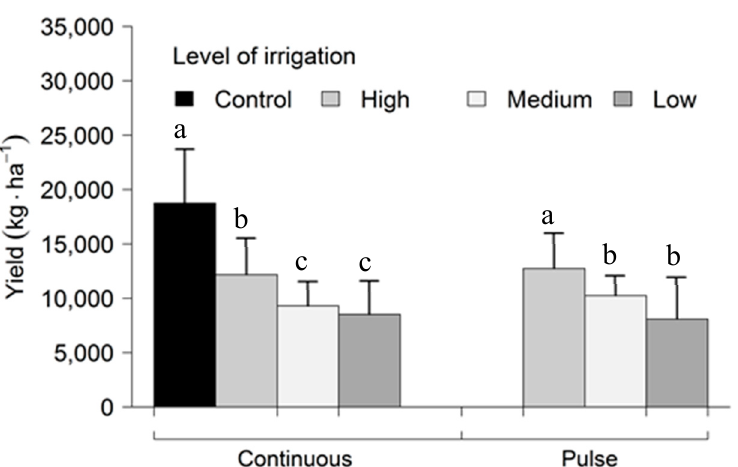
Figure 3. Fruit yield obtained from treatment plots based on the amount of water (high, medium, and low) and irrigation technique (continuous and pulse). Bars indicate standard deviation with overhead letters a, b, and c represent treatments that were significantly different at α = 0.05 for respective irrigation technique (continuous and pulse).